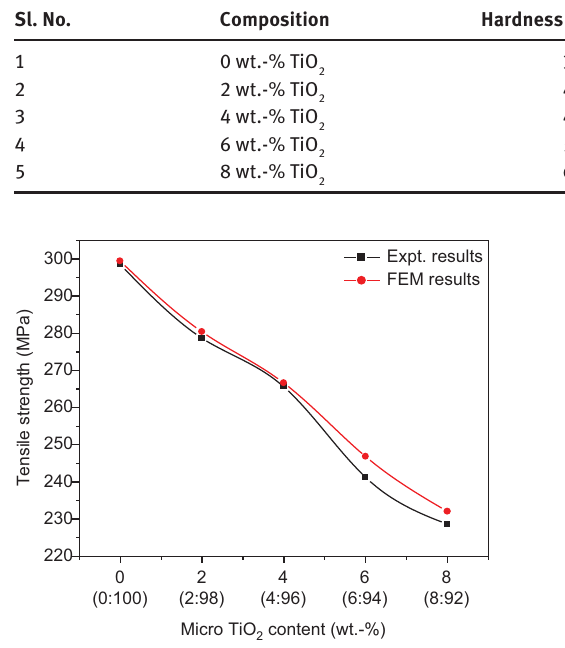
Figure 3 Effect of micro-TiO